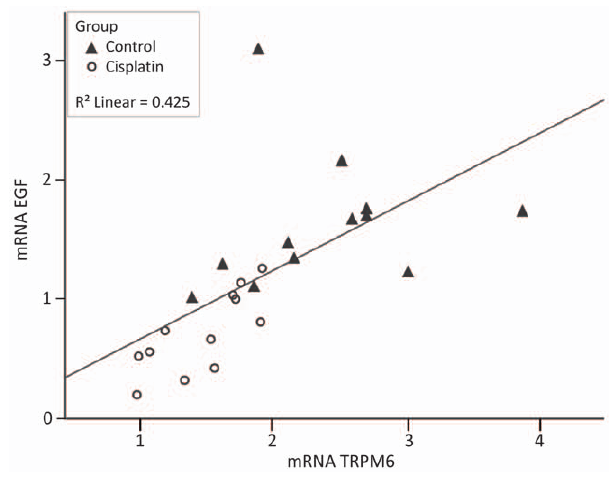
Figure 4. correlation between mRNA expression levels of TRPM6 and EGF. Data are presented per rat per group ( m controls, # cisplatin-treated rats). TRPM6 mRNA correlates with EGF mRNA expression level. Statistics were performed using a Pearson correlation